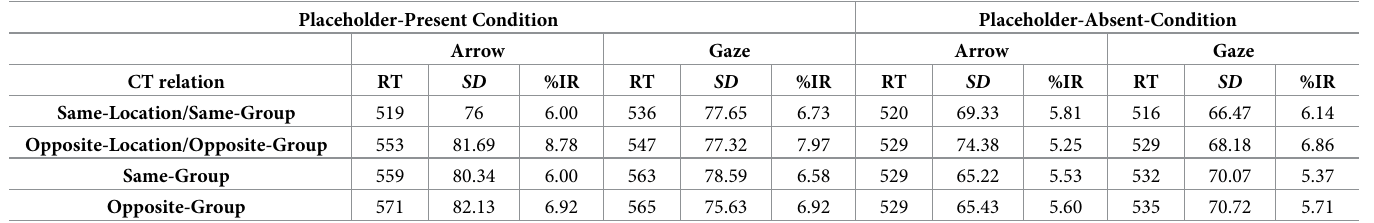
Table 2. Mean reaction times (RT), standard deviation (SD), and percentage of incorrect responses (%IR) as a function of placeholder-condition, type of cue, and cue-target (CT) relation in Experiment